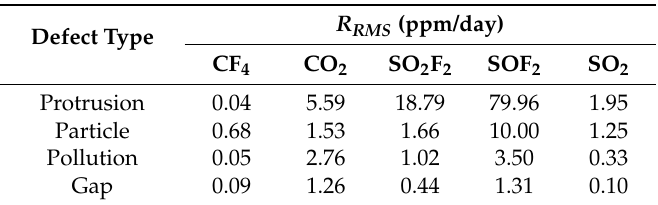
Table 3. Effective formation rates of SF 6 decomposed